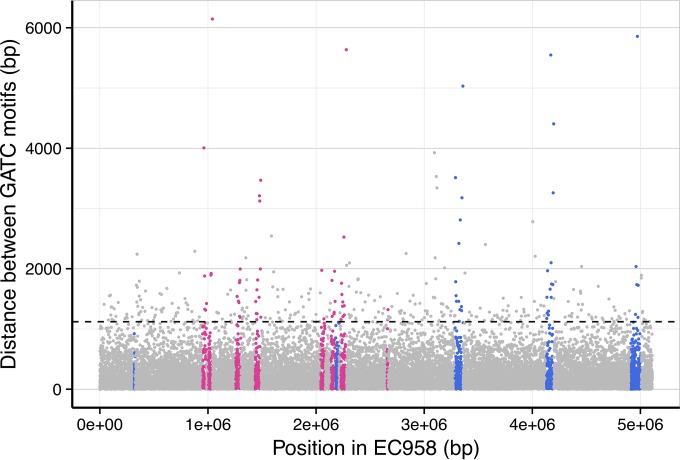
Distribution of GATC motifs in the core and accessory genome of E. coli EC958. The graph displays a linear representation of the EC958 chromosome showing the position of methylated GATC sites (x axis) and the distance between methylated GATC sites (y axis). Each GATC motif is represented by a single circle that has been colored based on its genomic context: genomic islands (GI-thrW, HPI, GI-pheV, GI-selC, and GI-leuX), blue; prophage (Phi1 to -7 and cryptic prophage), pink; core, gray. The dashed line denotes the boundary for outliers and is calculated as the mean distance between methylated GATC sites plus 3× the standard deviation.